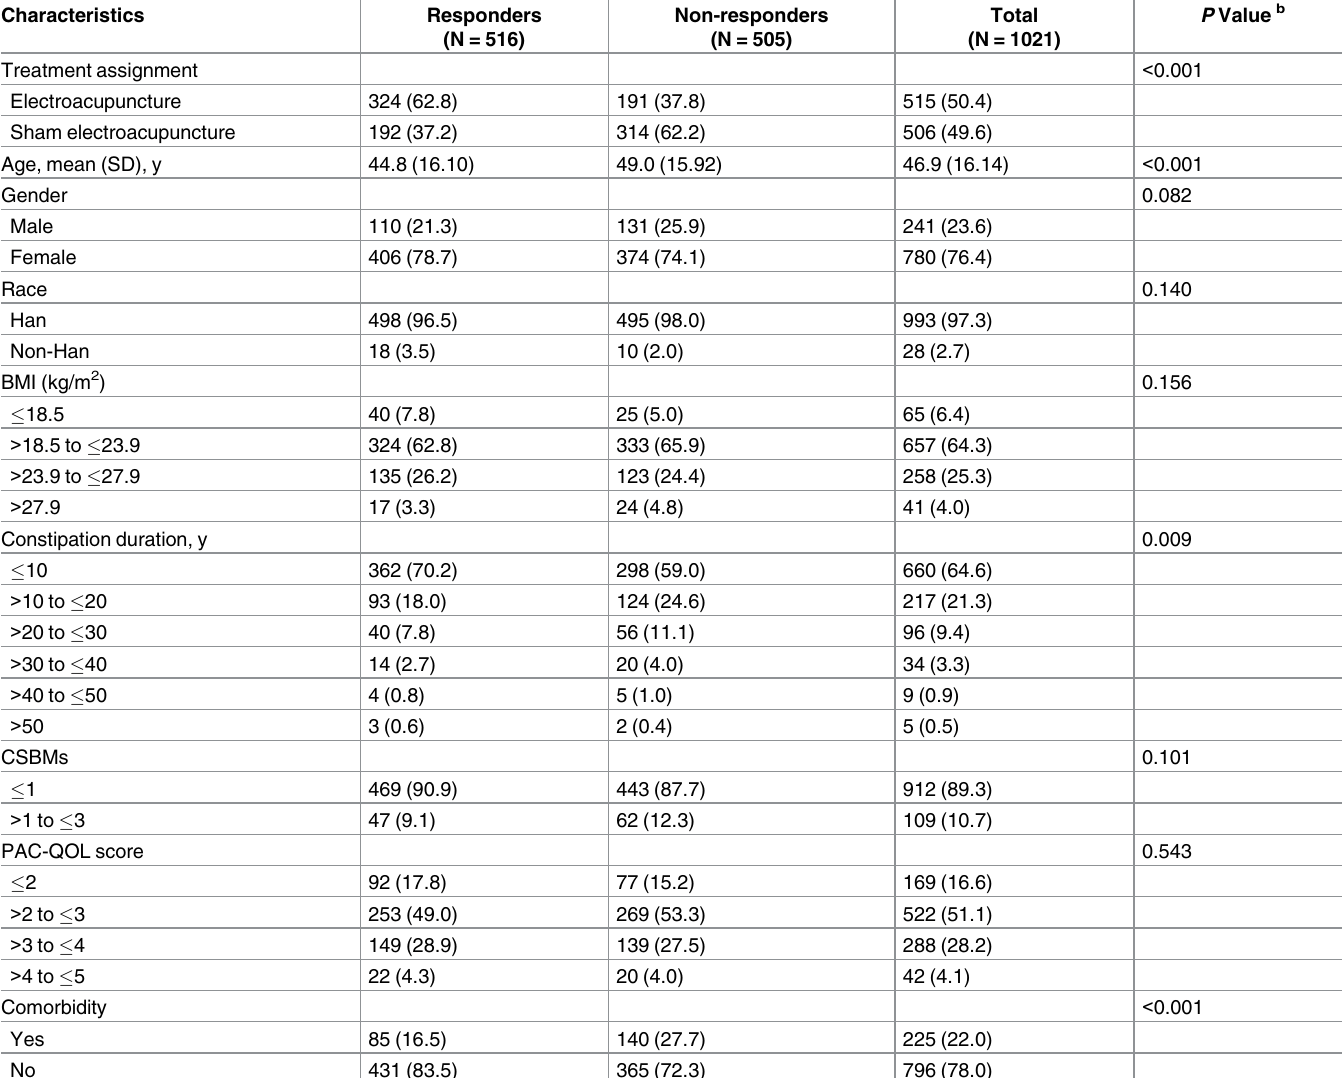
Table 1. Demographic and clinical characteristics of responders a